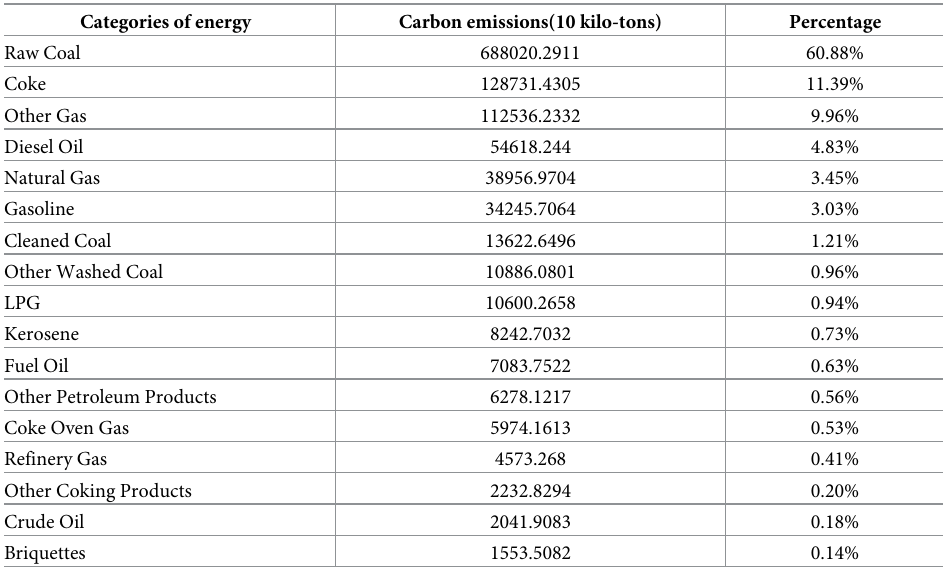
Table 4. CO 2 emissions from energy consumption.